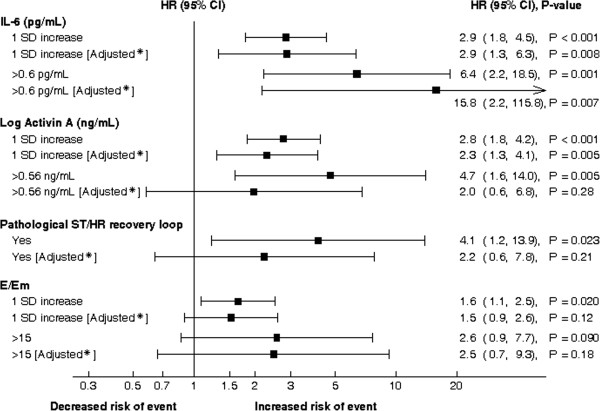
Unadjusted and adjusted hazard ratios for major CV events and death for the novel CV risk markers. * adjusted for age, gender, known CVD at inclusion, diastolic blood pressure, s-HDL-cholesterol, log microalbuminuria and s-creatinine. Abbreviations: CV = cardiovascular, IL-6 = Interleukin-6, SD = Standard Deviation.